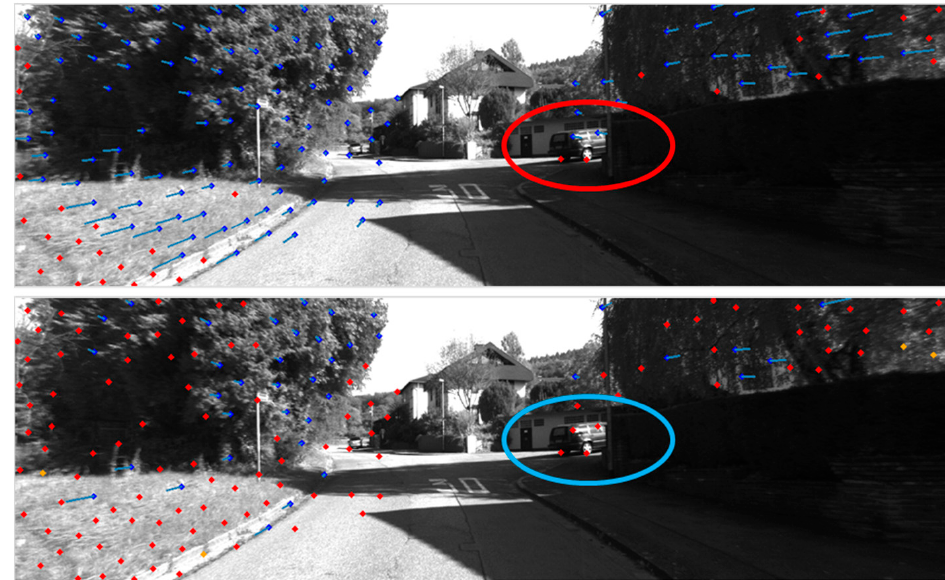
Figure 9. Top: before optimization (top image). Bottom: after optimization (sequence 03; frame 233). Figures 10–12 shows the photogrammetric feature optimization result within sequence 09. In the top images, the red point indicates an outlier removed by vision-based optimization, and the orange point indicates an outlier removed by photogrammetry-based optimization. We confirmed that the features for the moving object were removed in two steps. Remote Sens. 2019 , 11 , x FOR PEER REVIEW